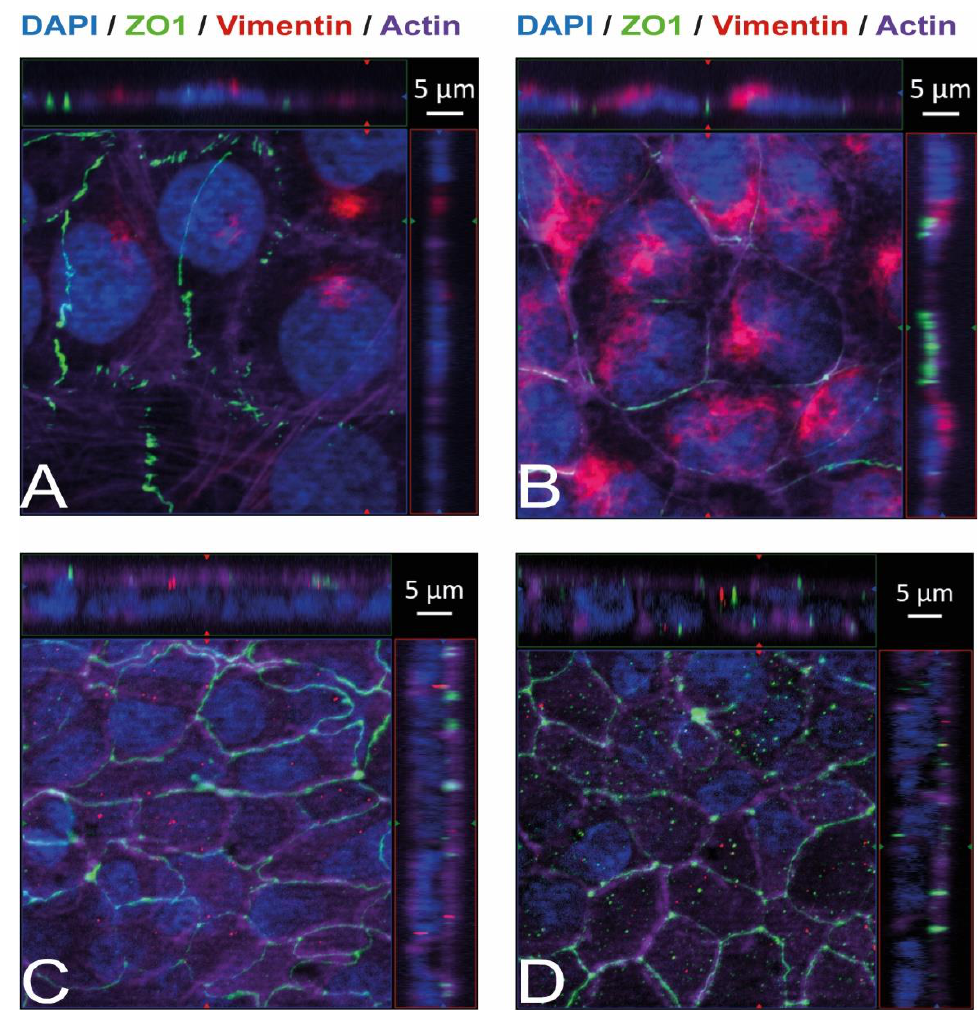
Figure 4. Vimentin, both intracellularly and on the cellular surface, is present in HBMEC but absent in HIBCPP cells. Immunofluorescence staining was performed with HBMEC ( A , B ) and HIBCPP cells ( C , D ). Vimentin staining is shown in red, the phalloidin-stained actin cytoskeleton is shown in purple, tight junctions are visualized via the staining of ZO1 (green), and nuclei are stained with DAPI (blue). The center part of each image displays an xy enface view presented as a maximum intensity through the z -axis of selected slices. The top and right-side parts of each panel are cross sections through the z-plane of multiple optical slices. The apical sides of HBMEC and HIBCPP cells are oriented toward the top of the top part and towards the right of the right part of each panel, respectively. Samples presented on the left ( A , C ) were not permeabilized before the binding of the anti-vimentin antibody and, therefore, show only vimentin present on the surface of the cells. Samples presented on the right ( B , D ) were permeabilized before the binding of the anti-vimentin antibody and, therefore, show the total vimentin present in the cells.